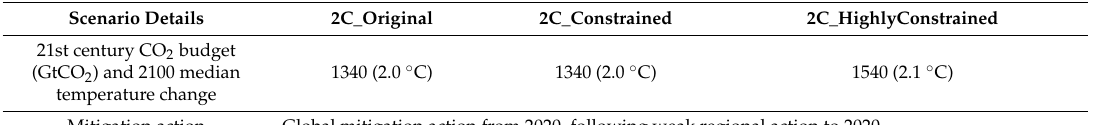
Table 4. Description of the scenarios compared in this